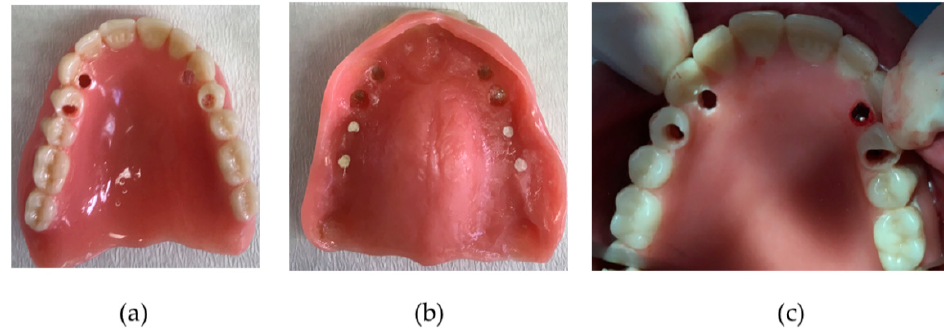
Figure 2. Provisional denture as a surgical guide. ( a ) palatal view; ( b ) mucosal view; ( c ) intra ‐ operative view with direction pin visible in the prepared burr hole region 2.3.